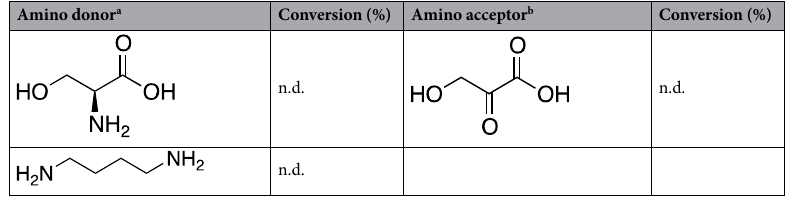
Table 1. Substrate scope of VbTA T16F. Each reaction was performed in triplicate and the results are reported as the average of the data obtained after 24 h. Substrates were prepared in methanol solution to guarantee the correct concentration of the substrate in the reaction mixture (final concentration 10% (v/v) MeOH). Final conversions were determined by HPLC. a Amino donor concentration was kept constant at 10 mM, and 10 mM pyruvate was used as the amino acceptor; b amino acceptor concentration was kept constant at 10 mM; L-alanine was used as the amino donor. n.d. = non-detectable in the tested condition.